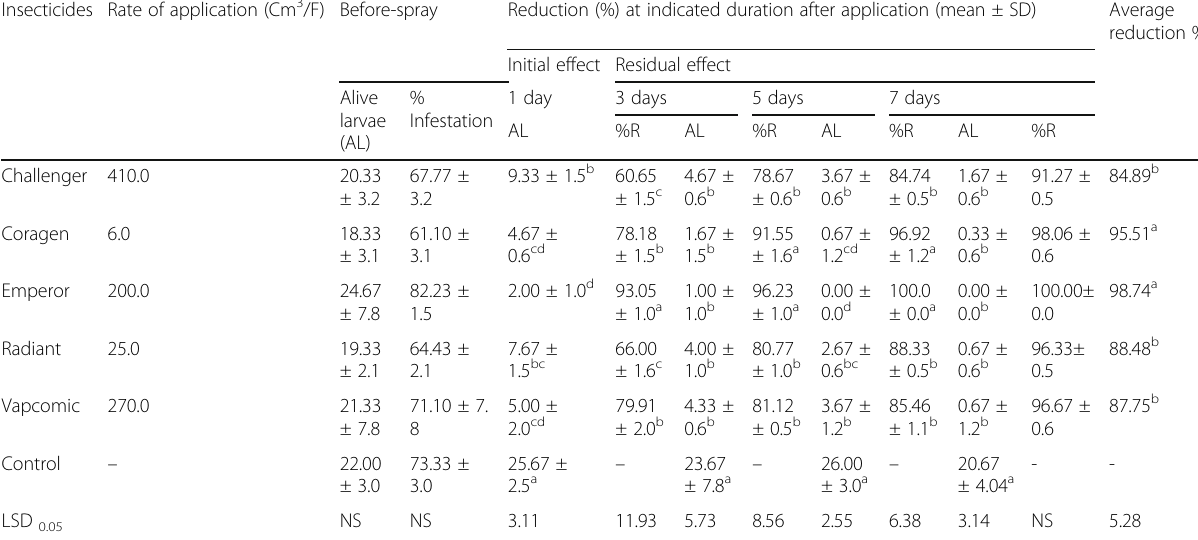
Table 5 Reduction percentages of Tuta absoluta infestation treated with the most potent insecticides Insecticides Rate of application (Cm 3 /F) Before-spray Reduction (%) at indicated duration after application (mean ±